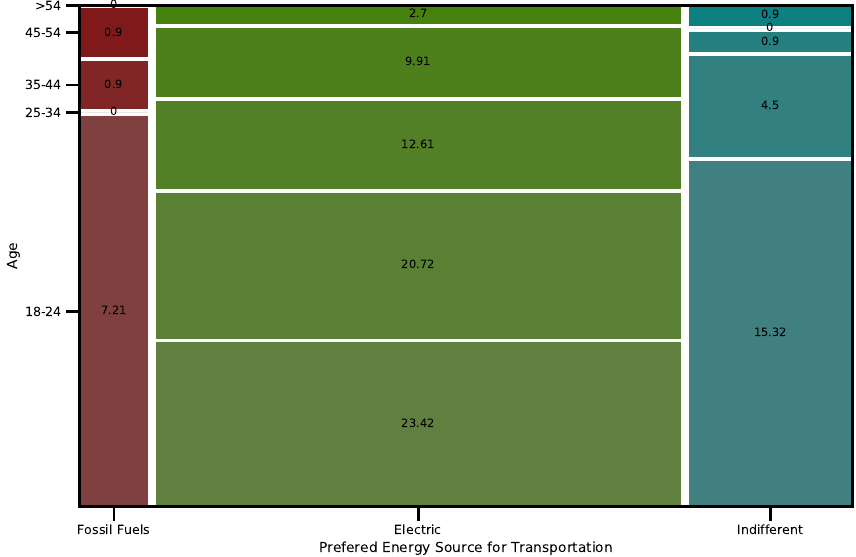
Figure 2. Mosaic plot of the preferred energy source for transportation based on age.